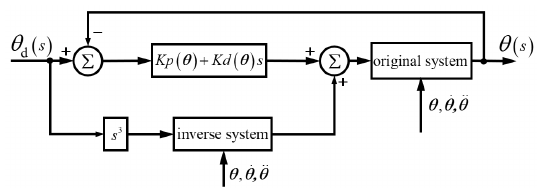
Figure 5. System function block diagram of a single joint.